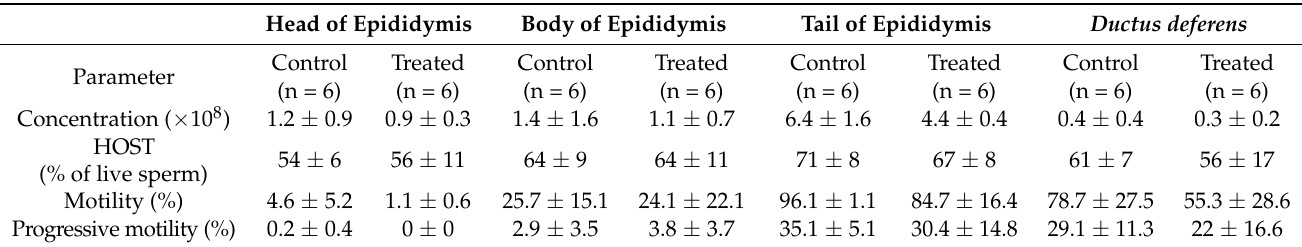
Table 5. Concentration, HOST, progressive motility, and normal morphology of ram spermatozoa after two months of treatment vs. non-treatment. The mean values and standard deviations (SD) are